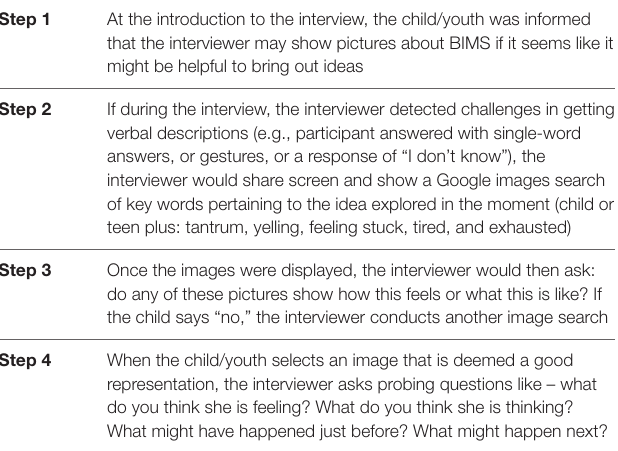
TABLE 2 | Description of using visual images to support interviews. TABLE 3 | Renaming BIMS phenomena using the autistic children and youth’s